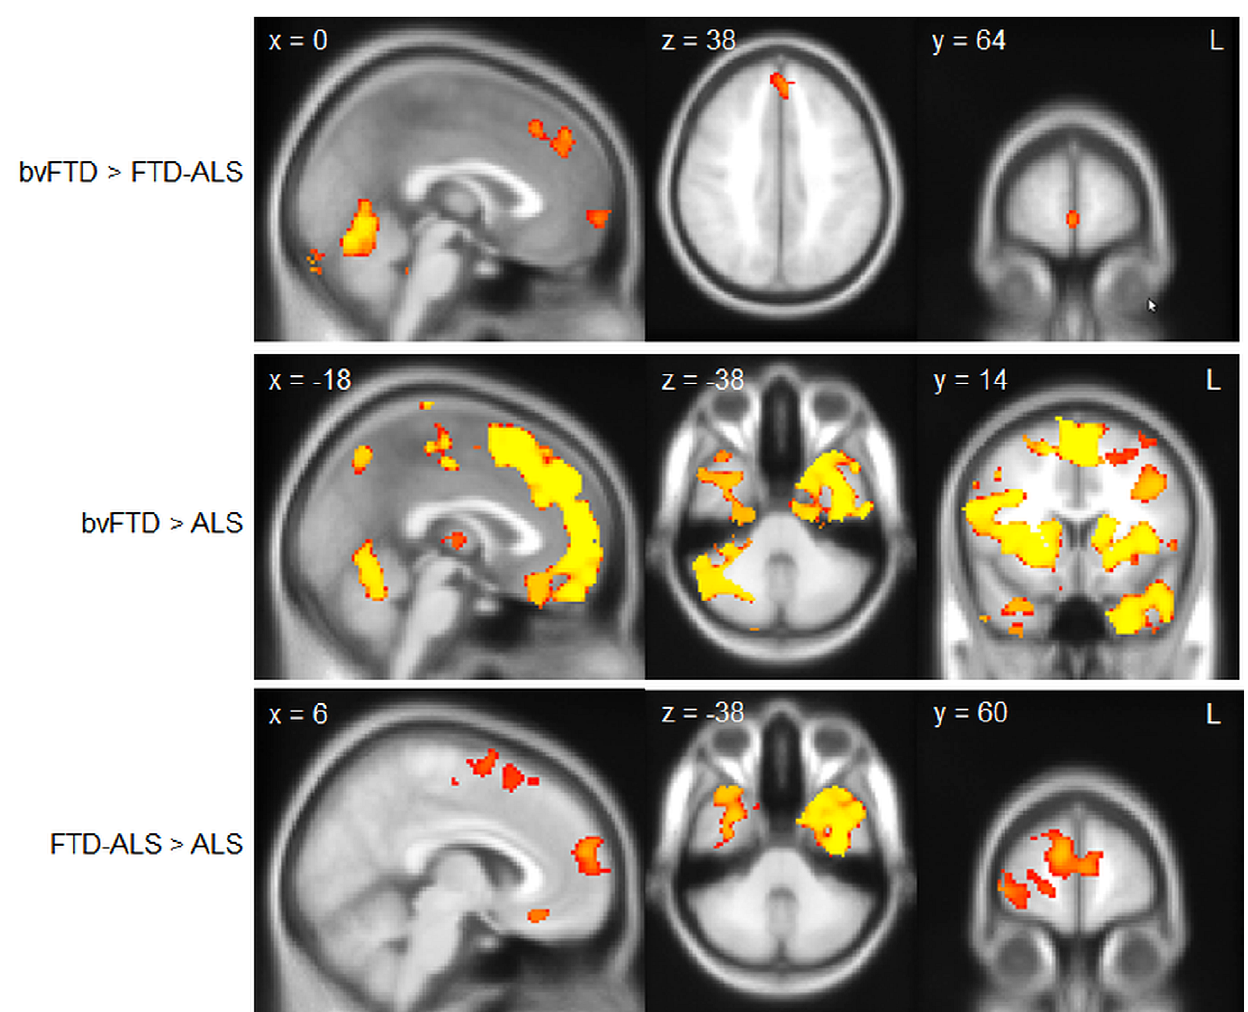
Figure 1. Unique grey matter atrophy across patient groups. Voxel-based morphometry analysis showing regions of unique brain atrophy across groups. Clusters are overlaid on the MNI standard brain (t=2.41). Coloured voxels show regions that were significant in the analyses for p , 0.05 FWE corrected.